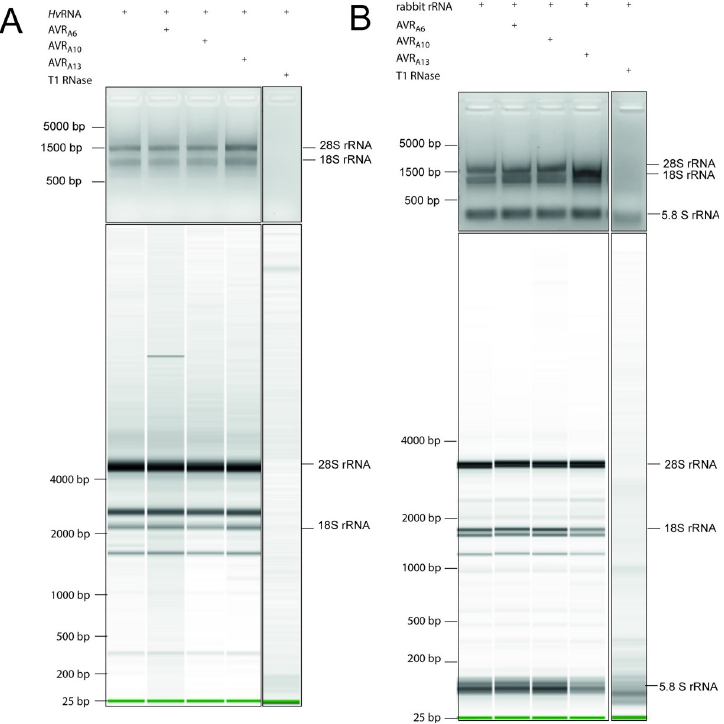
Fig 4. Recombinant AVR A6 , AVR A10 , and AVR A13 effector proteins do not exhibit ribonuclease activity. To test for ribonuclease activity, heterologous AVR A6 , AVR A10 , and AVR A13 proteins, purified upon expression of the respective genes in E . coli , or T1 RNase were co-incubated with (A) denatured Hv RNA and (B) native rabbit rRNA always. All samples were separated on non-denaturing 2% agarose gels (top panels) and analysed on a Bioanalyzer (lower panels) to check for RNA